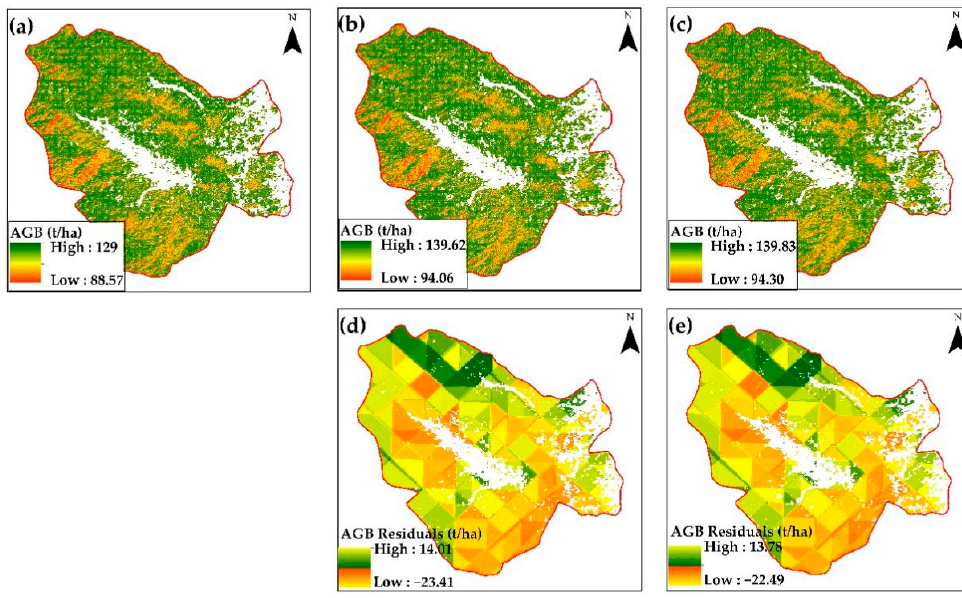
Figure 9. The estimated AGB of evergreen forests in the NM from ( a ) RF, ( b ) RFOK, and ( c ) RFCK models, and the calculated residuals for ( d ) RFOK and ( e ) RFCK models.